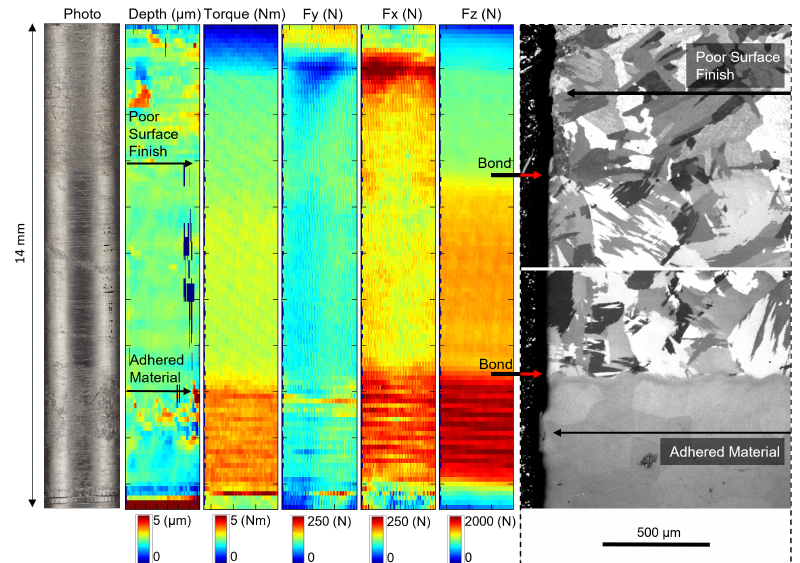
Figure 4. A photograph of the drilled surface, micrographs of the bond interfaces and depth, torque, Fy, Fx and Fz maps for holes drilled at 1845 RPM and F rev = 0.131 mm/rev in the Ti-CP-Ti-64-Beta C workpiece (three alloy sample).